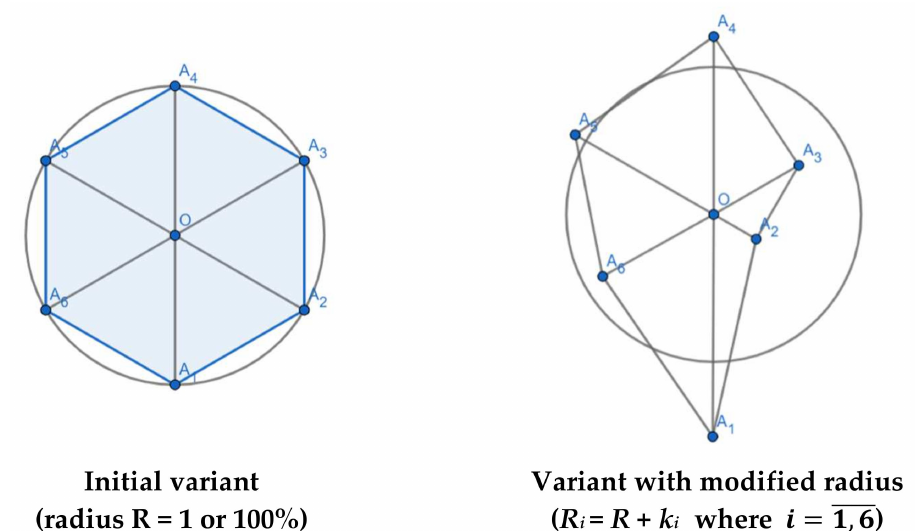
Figure 5. MID-specific dual graphics in “ 6-gon ”